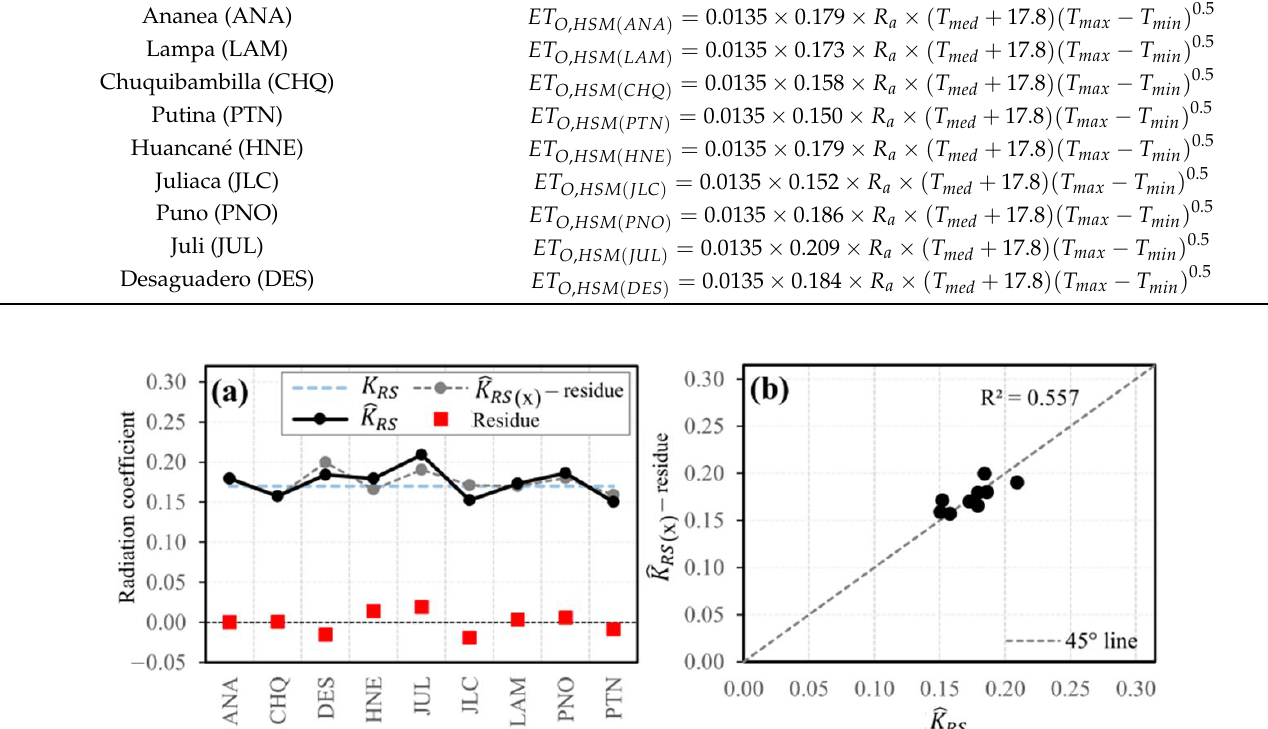
Figure 7. Spatial distribution of the radiation coefficient 𝐾̂ 𝑅𝑆(𝑥) .